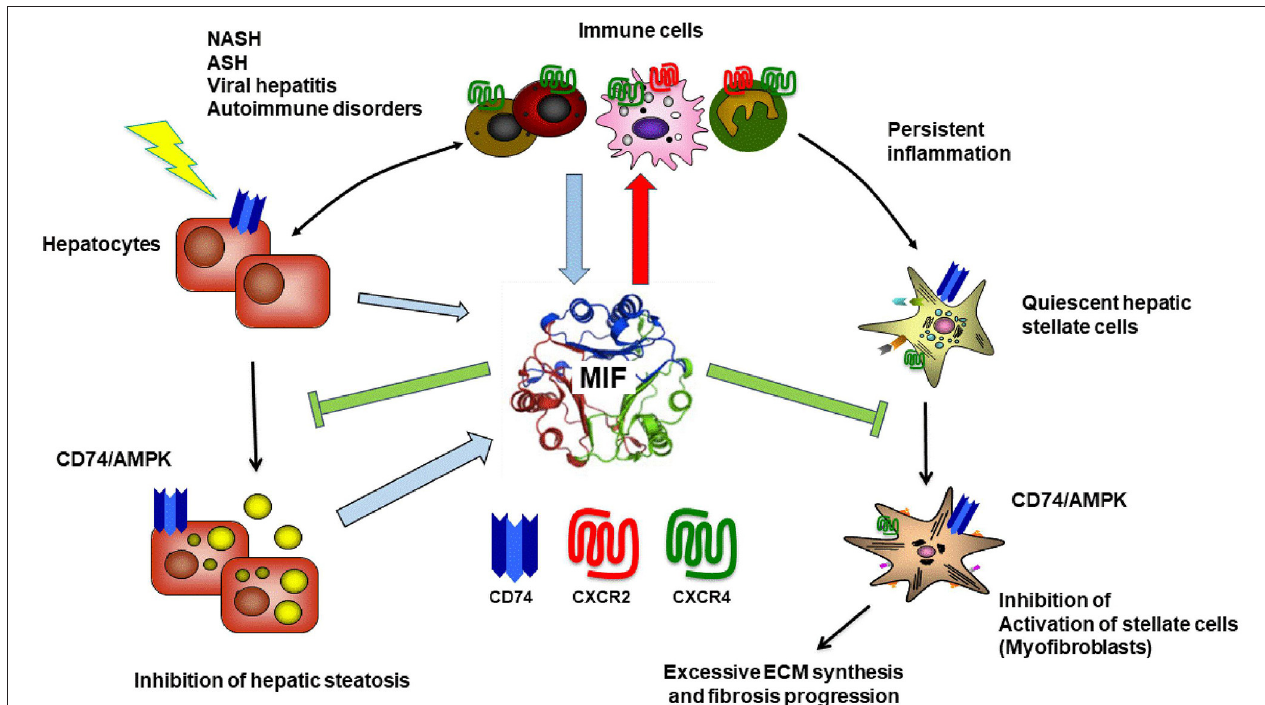
FIGURE 6 | Macrophage migration inhibitory factor in chronic liver injury and fibrogenesis. In the liver, the atypical chemokine Macrophage migration inhibitory factor (MIF) is mostly expressed by infiltrating immune cells as well as hepatocytes especially under stress condition e.g., fatty degeneration or inflammation during NASH, ASH and viral hepatitis. In addition, it is most likely that MIF is involved in the pathogenesis of hepatic autoimmune disorders because this cytokine was previously shown to be associated with many autoimmune disorders including rheumatoid arthritis, inflammatory arthritis, inflammatory bowel disease, multiple sclerosis, autoimmune uveitis., autoimmune glomerulonephritis, systemic lupus erythematosus, sarcoidosis and many other autoimmune inflammatory disorder [for review see ( 85, 100)]. MIF engages high-affinity non-cognate interactions with three different surface receptors expressed by liver resident cells as well as infiltrating cells, the CXC chemokine receptors CXCR2 and CXCR4 as well as with CD74, the membrane form of invariant chain (Ii). While MIF engagement with the CD74 receptor on hepatocytes and hepatic stellate cells exert protective effect via AMPK signaling during chronic liver injury, MIF also mediates pro-inflammatory effects orchestrating the intrahepatic recruitment and activation of inflammatory immune cells via engagement of CXCR2 and CXCR4. The balance between these opposing, regulatory roles of the MIF/receptor network is crucial for the overall impact of MIF on severity and progression of chronic liver disease in distinct settings and has to be considered when designing MIF-directed therapeutic strategies. Blue arrow indicates MIF release. Red arrow marks pro-inflammatory properties and green arrow protective features of MIF on respective